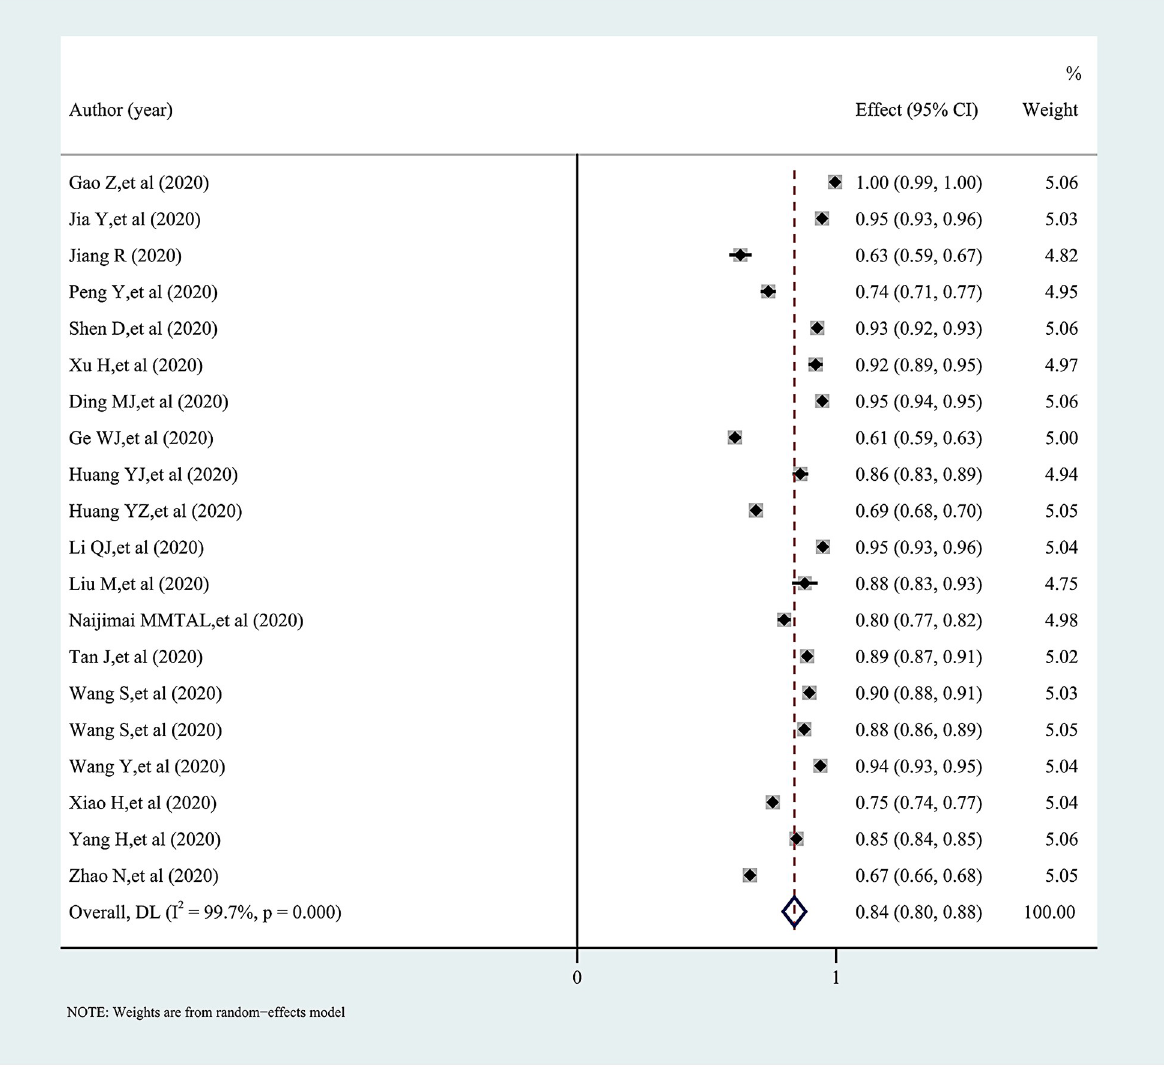
Fig 3. Forest plot showing the pooled proportion of positive attitudes towards COVID-19 among study